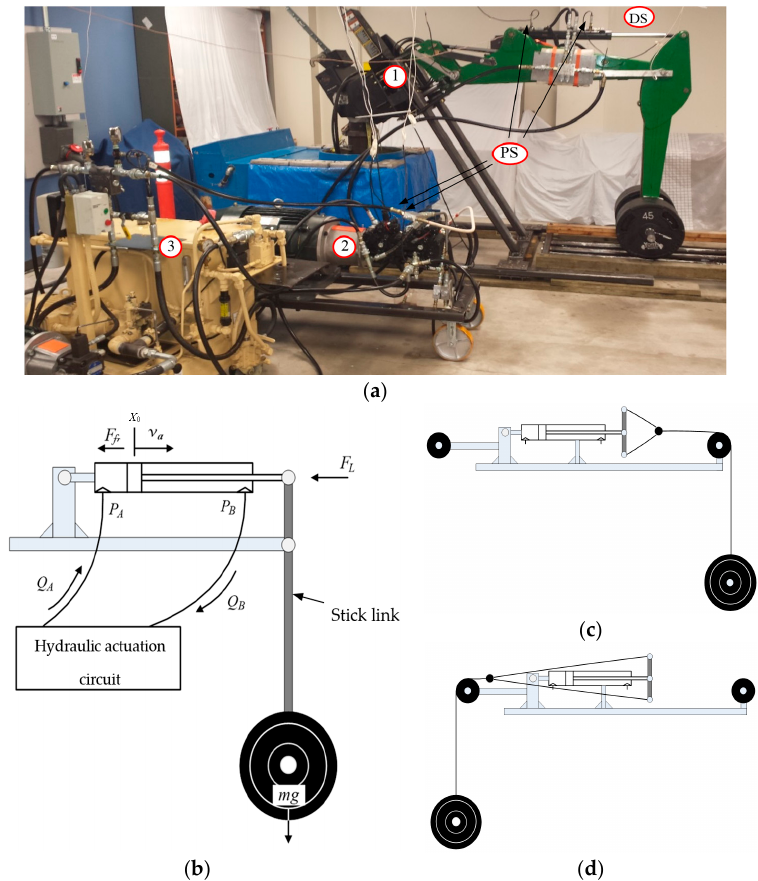
Figure 4. Experimental test rig: ( a ) main components: (1) JD-48 backhoe attachment, (2) main pump unit, (3) charge pump unit, (PS) pressure sensors, and (DS) displacement sensor; ( b ) full setup schematic; ( c ) reconfigured setup to test the second and third quadrants; and ( d ) reconfigured setup to test the first and fourth quadrants.